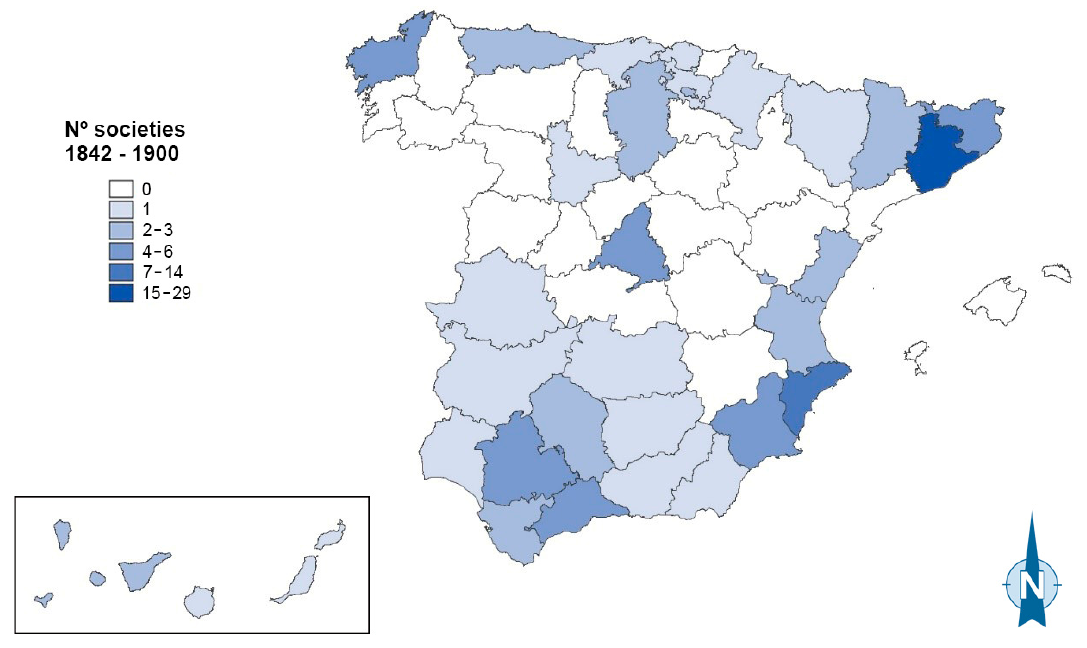
Figure 4. Regional distribution of water companies (1842–1900).